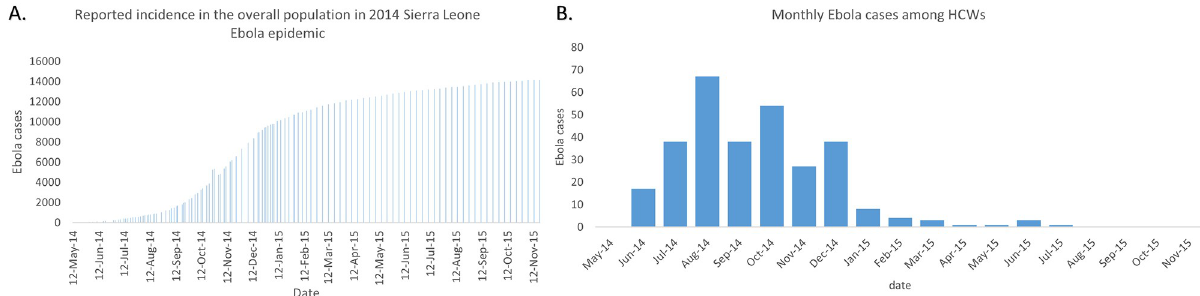
Fig 1. Reported Ebola cases for 2014–2015 Sierra Leone epidemic among overall population and among HCWs. Data for the overall population cases were reported by WHO [32] and data for HCW cases were collected by Fang et al. [33]. A: Reported incidence in the overall population in 2014– 2015 Sierra Leone epidemic(cumulative cases). B: Weekly Ebola cases among HCWs(weekly